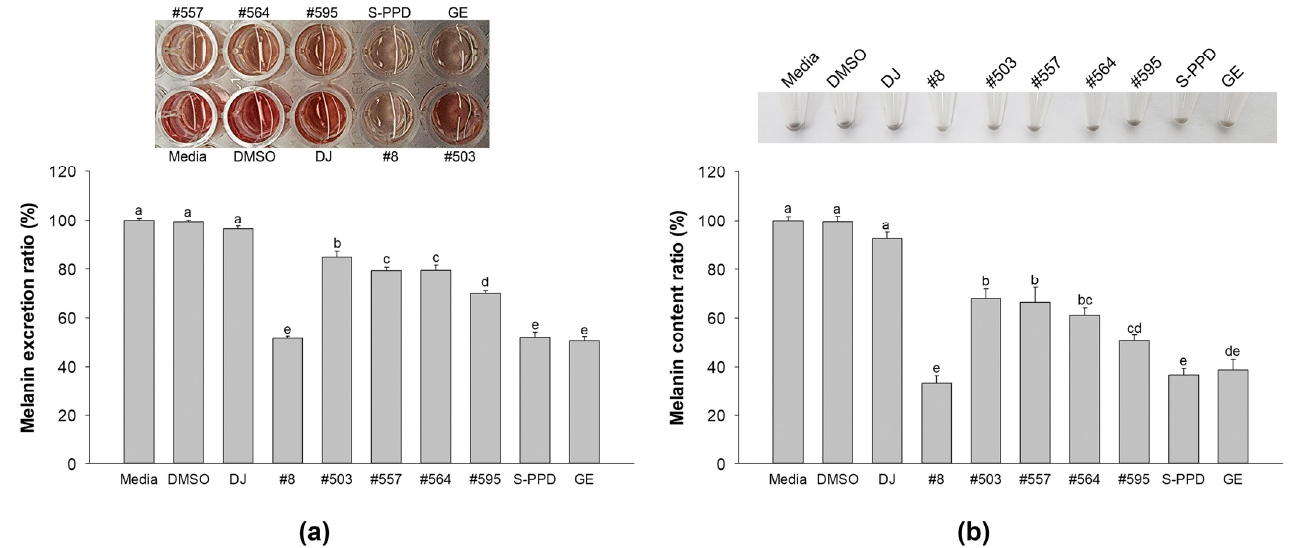
Figure 3. Effects of the PPD-enriched transgenic rice seed extracts on melanin excretion and melanin content. Effects on ( a ) melanin excretion and ( b ) melanin content. DJ, #8, #503, #557, #564, and #595 concentrations were 100 µg/mL. DMSO, S-PPD, and GE concentrations were 0.1%, 700 pg/mL, and 100 µg/mL, respectively. Data are shown as mean ± standard deviation ( n = 3). Lowercase letters